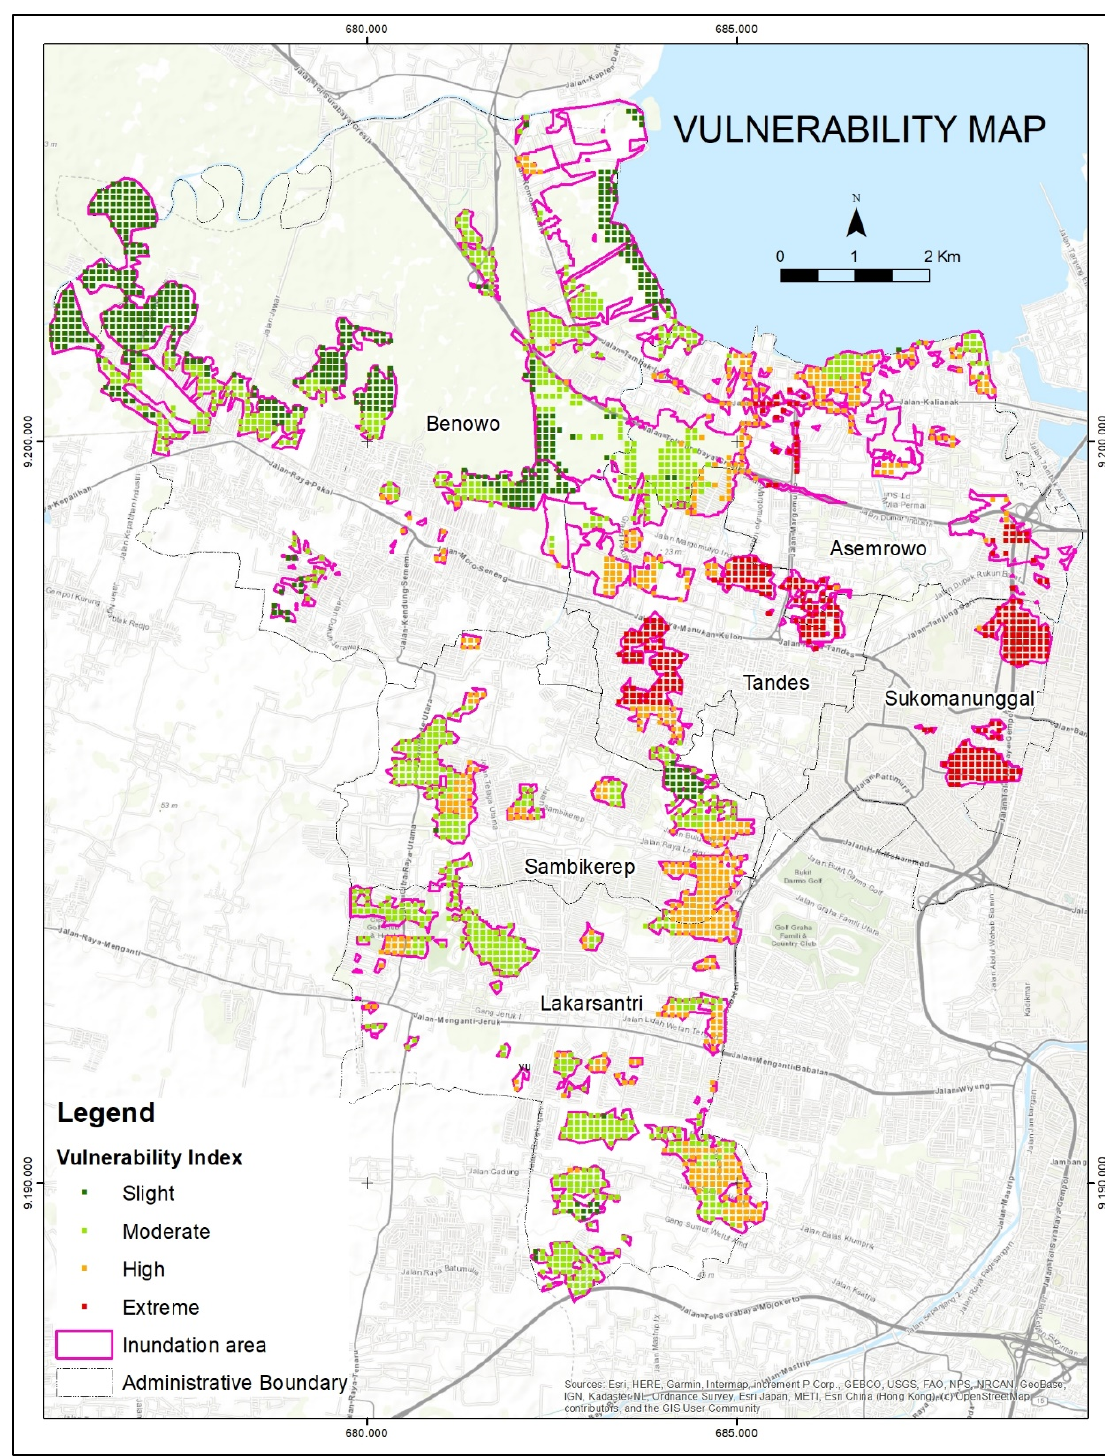
Figure 7. Vulnerability Map. Table 3. The distribution of impacted population by district.